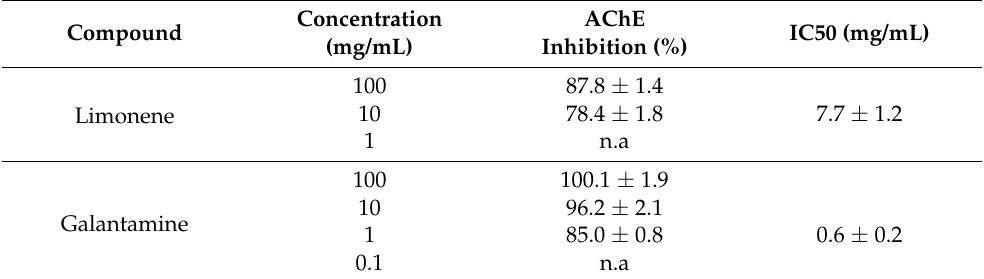
Table 1. Inhibitory effects of limonene on AChE activity. Concentration-dependent effect of limonene and galantamine against AChE activity measured in vitro (n.a. = not active). Concentration AChE IC50 (mg/mL) Compound (mg/mL) Inhibition (%) 100 87.8 ± 1.4 10 78.4 ± 1.8 7.7 ± 1.2 Limonene 1 n.a 100 100.1 ± 1.9 10 96.2 ± Galantamine